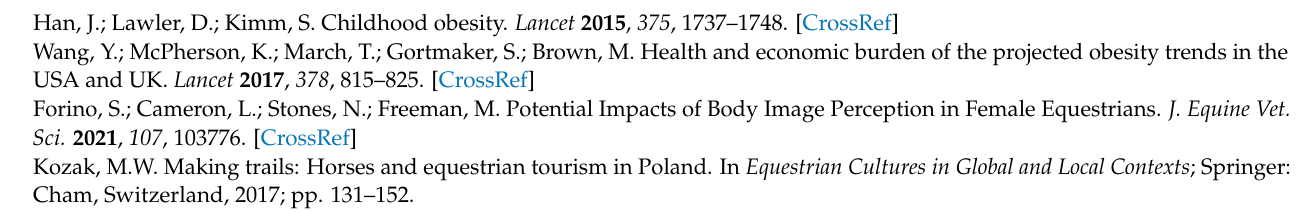
(L), moderate (M), and heavy (H) groups. The pre-exercise (pre-ex) and post-exercise (post-ex) data series were compared; Table S8: The right area of back musculature (ROI 4). Values (mean ± SD) of histogram statistics (HS) features for three color components (R, red; G, green; B, blue) in light (L), moderate (M), and heavy (H) groups. The pre-exercise (pre-ex) and post-exercise (post-ex) data series were compared; Table S9: The withers area (ROI 1). Values (mean ± SD) of gray-level run-length matrix (GLRLM) features for three color components (R, red; G, green; B, blue) in light (L), moderate (M), and heavy (H) groups. The pre-exercise (pre-ex) and post-exercise (post-ex) data series were compared; Table S10: The thoracic spine area (ROI 2). Values (mean ± SD) of gray-level run-length matrix (GLRLM) features for three color components (R, red; G, green; B, blue) in light (L), moderate (M), and heavy (H) groups. The pre-exercise (pre-ex) and post-exercise (post-ex) data series were compared; Table S11: The left area of back musculature (ROI 3). Values (mean ± SD) of gray-level run-length matrix (GLRLM) features for three color components (R, red; G, green; B, blue) in light (L), moderate (M), and heavy (H) groups. The pre-exercise (pre-ex) and post-exercise (post-ex) data series were compared; Table S12: The right area of back musculature (ROI 4). Values (mean ± SD) of gray-level run-length matrix (GLRLM) features for three color components (R, red; G, green; B, blue) in light (L), moderate (M), and heavy (H) groups. The pre-exercise (pre-ex) and post-exercise (post-ex) data series were compared; Table S13: The withers area (ROI 1). Values (mean ± SD) of gray level co-occurrence matrix (GLCM) features for three color components (R, red; G, green; B, blue) in light (L), moderate (M), and heavy (H) groups. The pre-exercise (pre-ex) and post-exercise (post-ex) data series were compared; Table S14: The thoracic spine area (ROI 2). Values (mean ± SD) of gray level co-occurrence matrix (GLCM) features for three color components (R, red; G, green; B, blue) in light (L), moderate (M), and heavy (H) groups. The pre-exercise (pre-ex) and post-exercise (post-ex) data series were compared; Table S15: The left area of back musculature (ROI 3). Values (mean ± SD) of gray level co-occurrence matrix (GLCM) features for three color components (R, red; G, green; B, blue) in light (L), moderate (M), and heavy (H) groups. The pre-exercise (pre-ex) and post-exercise (post-ex) data series were compared; Table S16. The right area of back musculature (ROI 4). Values (mean ± SD) of gray level co-occurrence matrix (GLCM) features for three color components (R, red; G, green; B, blue) in light (L), moderate (M), and heavy (H) groups. The pre-exercise (pre-ex) and post-exercise (post-ex) data series were